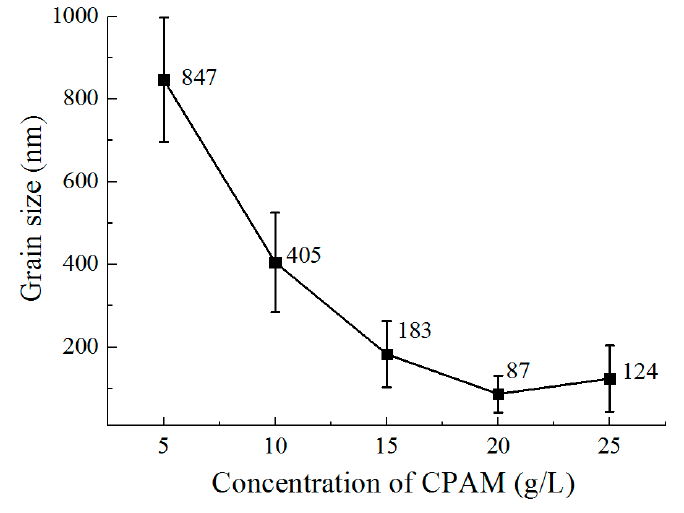
Figure 8. The grain size of deposition.